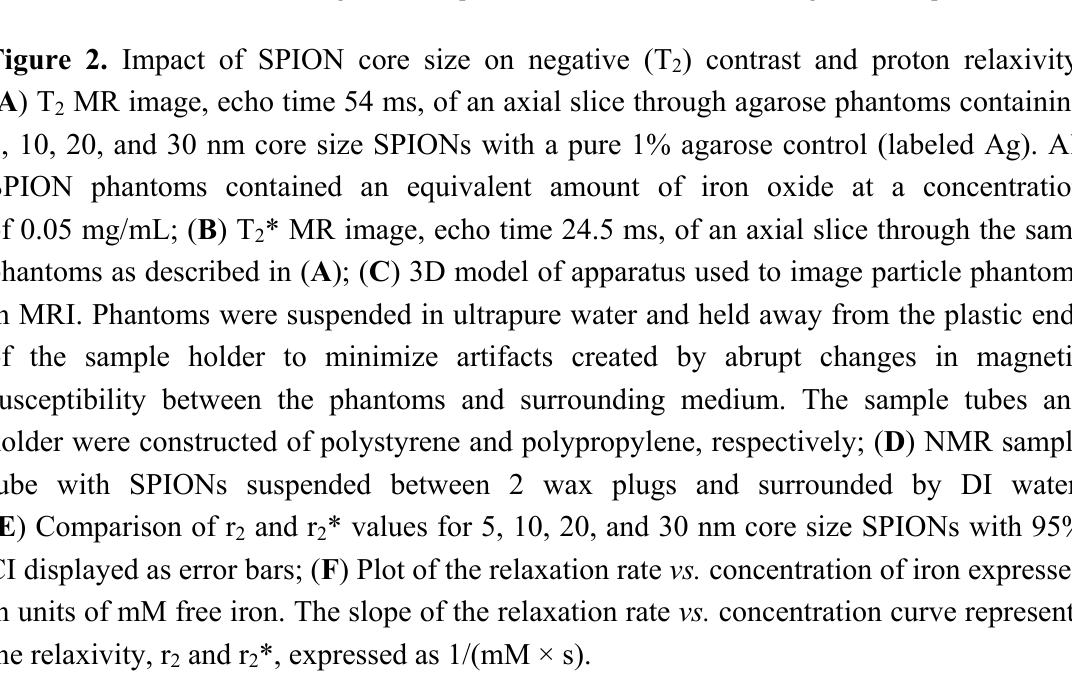
Figure 2. Impact of SPION core size on negative (T ) contrast and proton relaxivity. 2 MR image, echo time 54 ms, of an axial slice through agarose phantoms containing ( A ) T 2 5, 10, 20, and 30 nm core size SPIONs with a pure 1% agarose control (labeled Ag). All SPION phantoms contained an equivalent amount of iron oxide at a concentration of 0.05 mg/mL; ( B ) T * MR image, echo time 24.5 ms, of an axial slice through the same 2 phantoms as described in ( A ); ( C ) 3D model of apparatus used to image particle phantoms